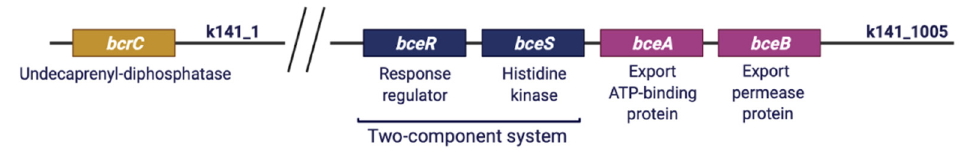
Figure 5. Genetic determinants of bacitracin resistance in MA-13.